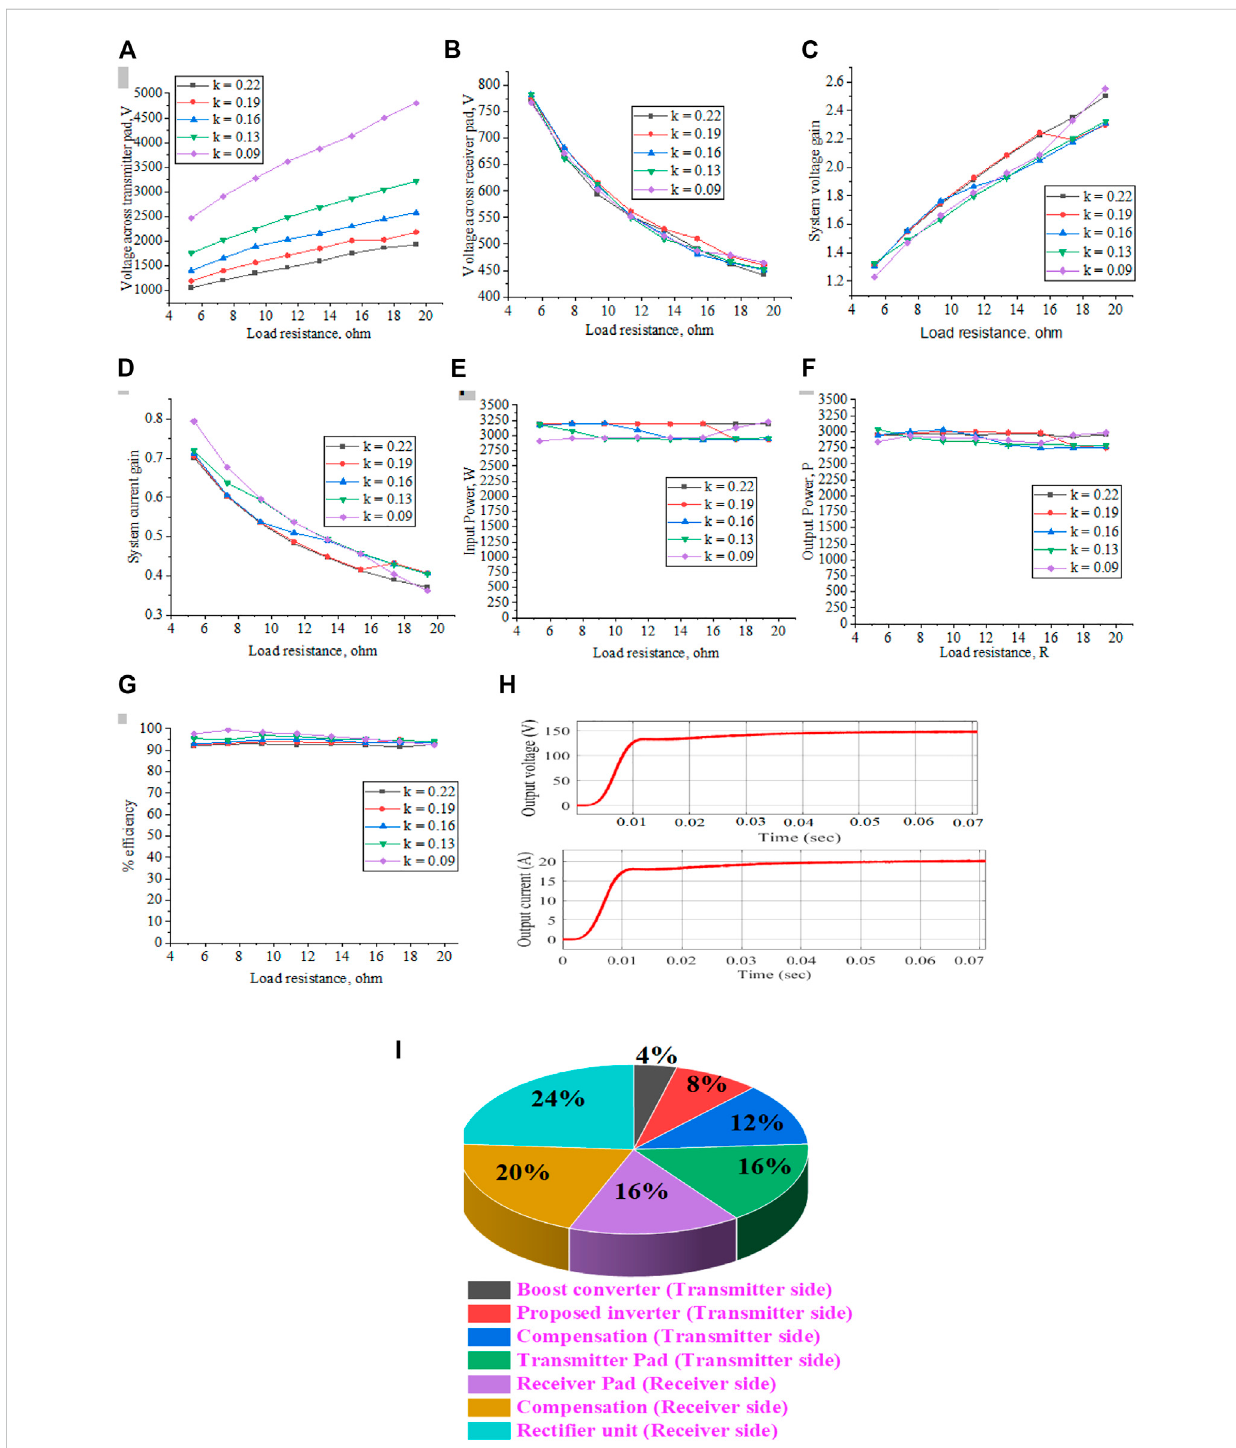
FIGURE 12 (A) R L vs. Voltage across transmitter pad (B) R L vs. Voltage across receiver pad (C) R L vs. overall system voltage gain (D) R L vs. overall system current gain (E) R L vs. input power (F) R L vs. output power (G) R L vs. %ef fi ciency (H) Output voltage and current waveforms for k = 0.22 (I) Loss distribution of the proposed